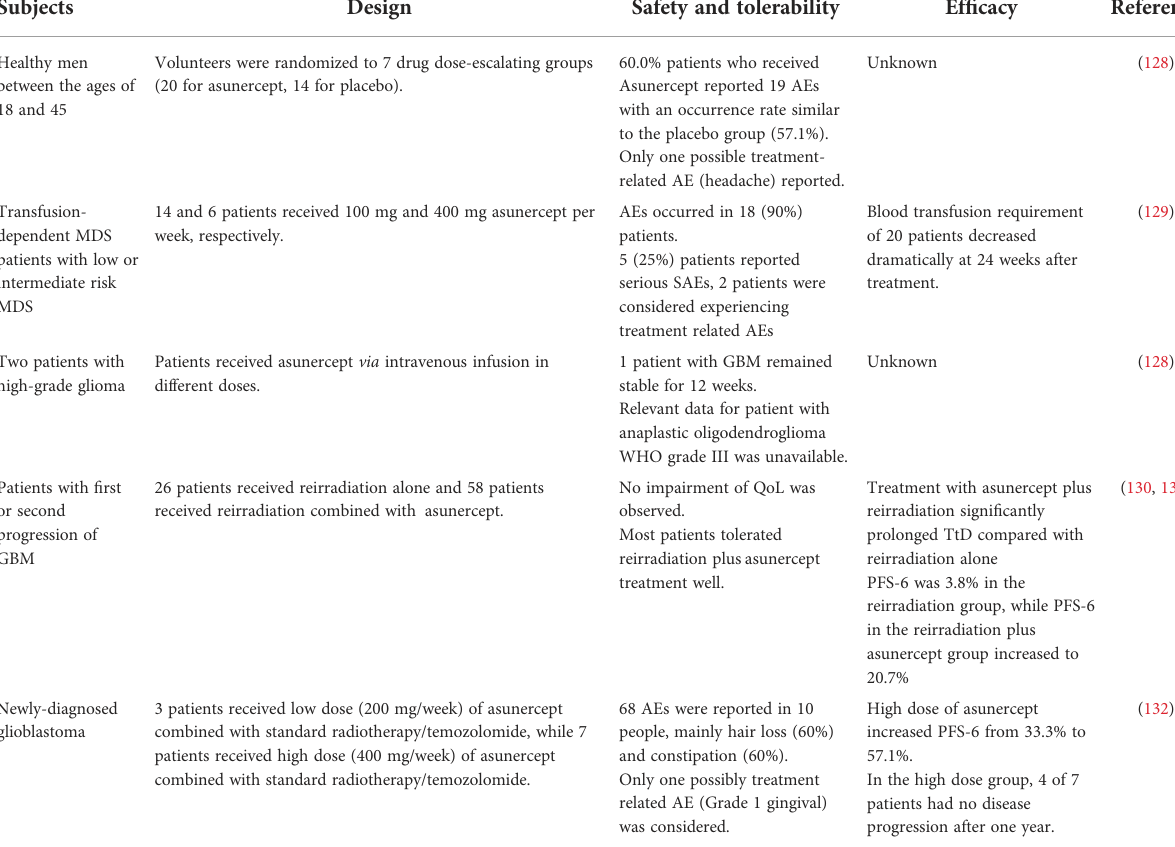
TABLE 1 Phase I/II trials of APG101 and their